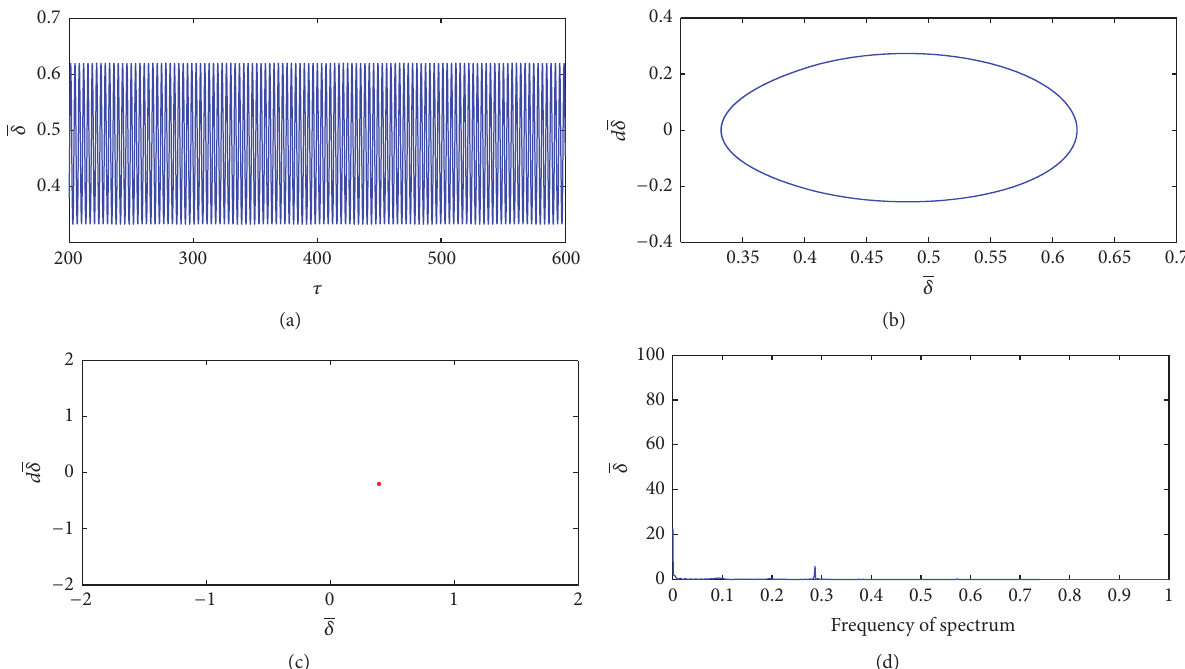
Figure 9: 𝜔 ℎ = 1.8 and 𝑓 = 2 : (a) time history; (b) phase plane; (c) Poincar´e map; (d) Fourier spectrum.